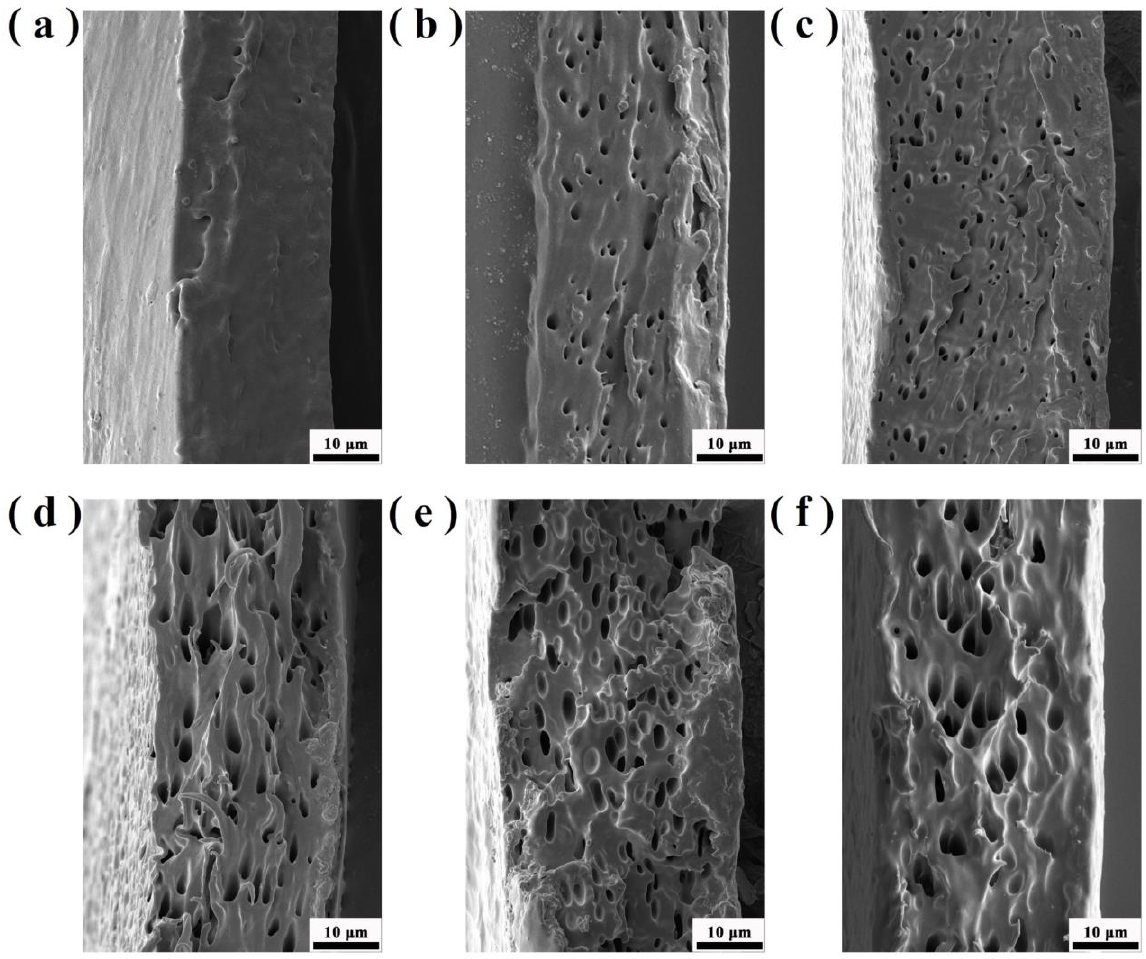
Figure 11. Tensile cross-sectional morphology of PO3G–PA/PLLA composite films at different scales. ( a ) Pure PLLA; ( b ) 5PO3G–PA/PLLA; ( c ) 10PO3G–PA/PLLA; ( d ) 15PO3G–PA/PLLA; ( e ) 20PO3G–PA/PLLA; ( f ) 25PO3G–PA/PLLA.